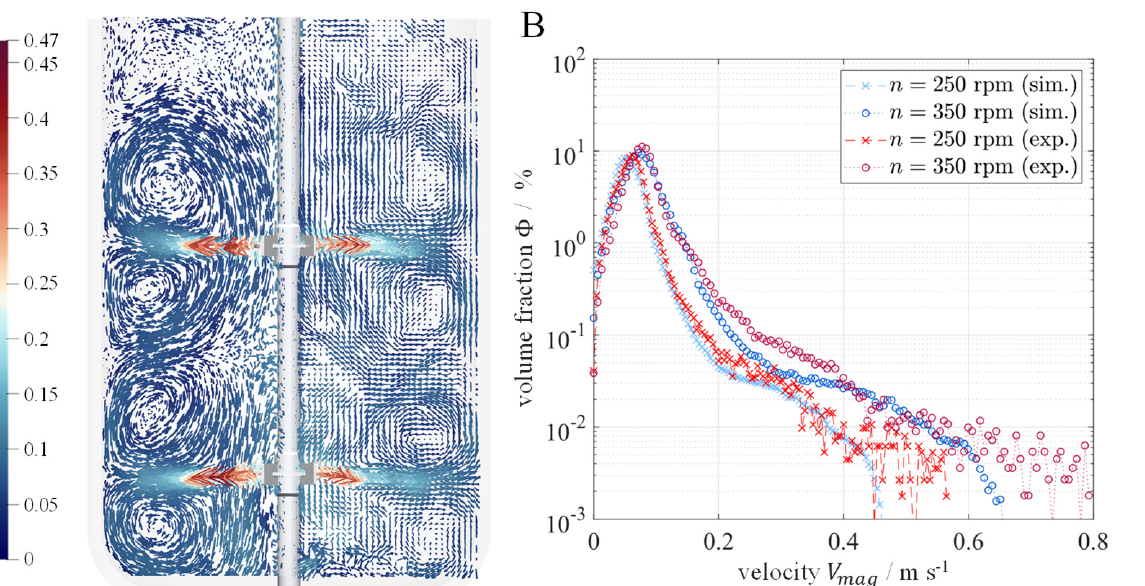
Figure 6. Comparison of the dimensionless axial time- and azimuthal-averaged velocity profiles.